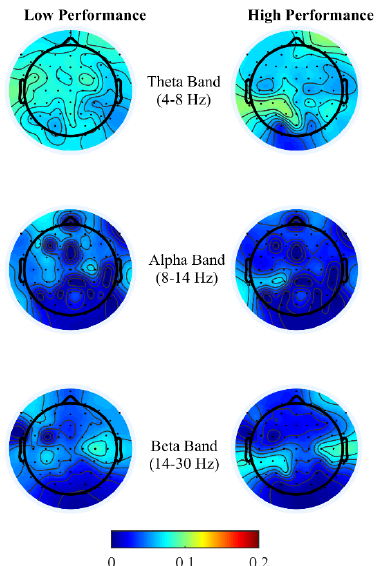
Figure 4. Scalp activities across EEG channels with non-zero LASSO coefficients from brain spectral power for low- and high-addition task performance.